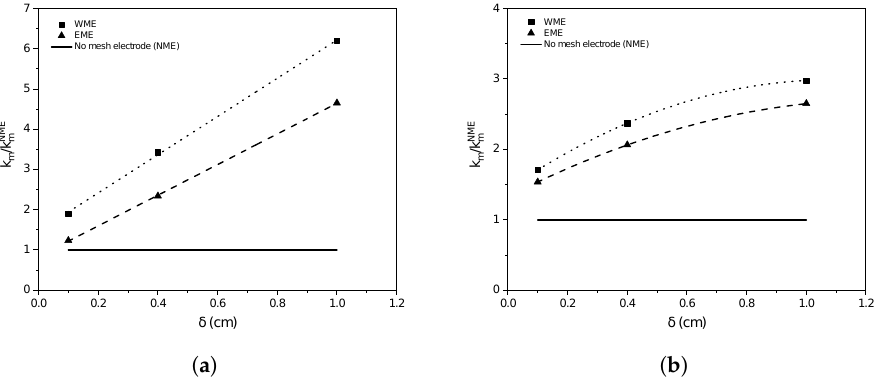
Figure 12. Mass transfer coefficient obtained with constant w (0.6 cm) and varying δ in ( a ) laminar and ( b ) turbulent